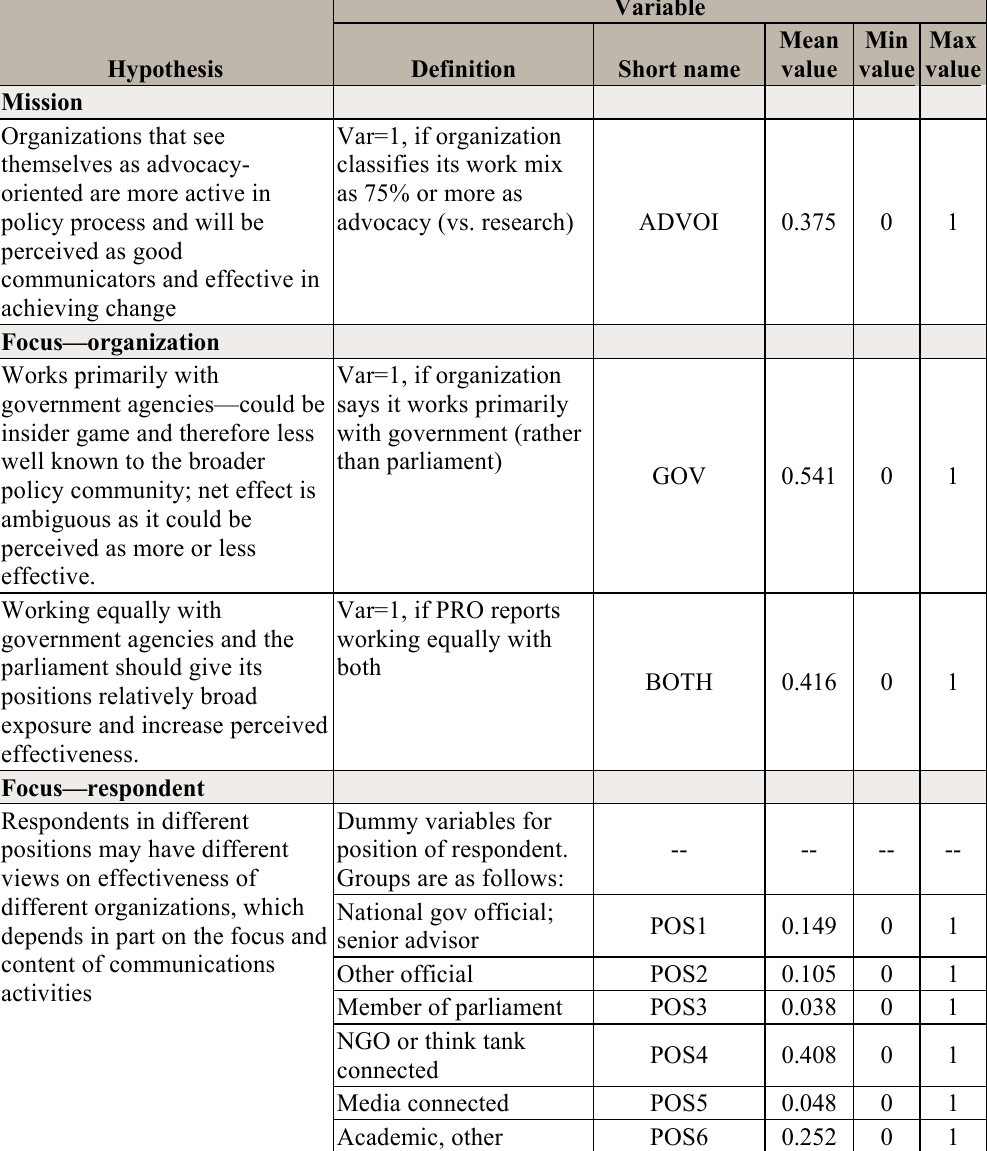
Table 2. Hypotheses on Factors Affecting Effectiveness in the Policy Arena, Corresponding Variable Definitions, and Summary